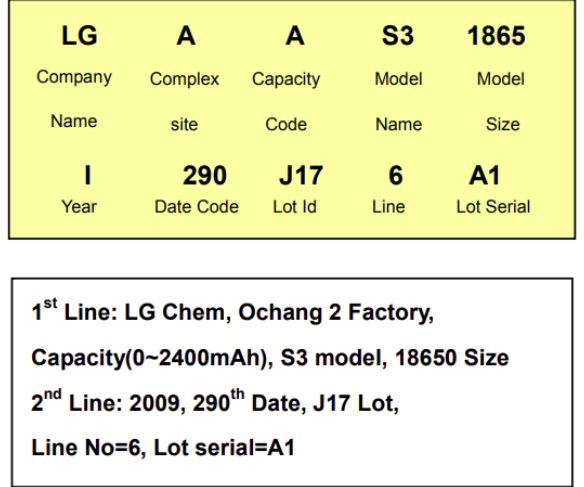
Figure 6. Interpretation of text printed on the outer casing [45]. Table 1. Comparison of the text printed on the outer casing of the three batteries. Cell